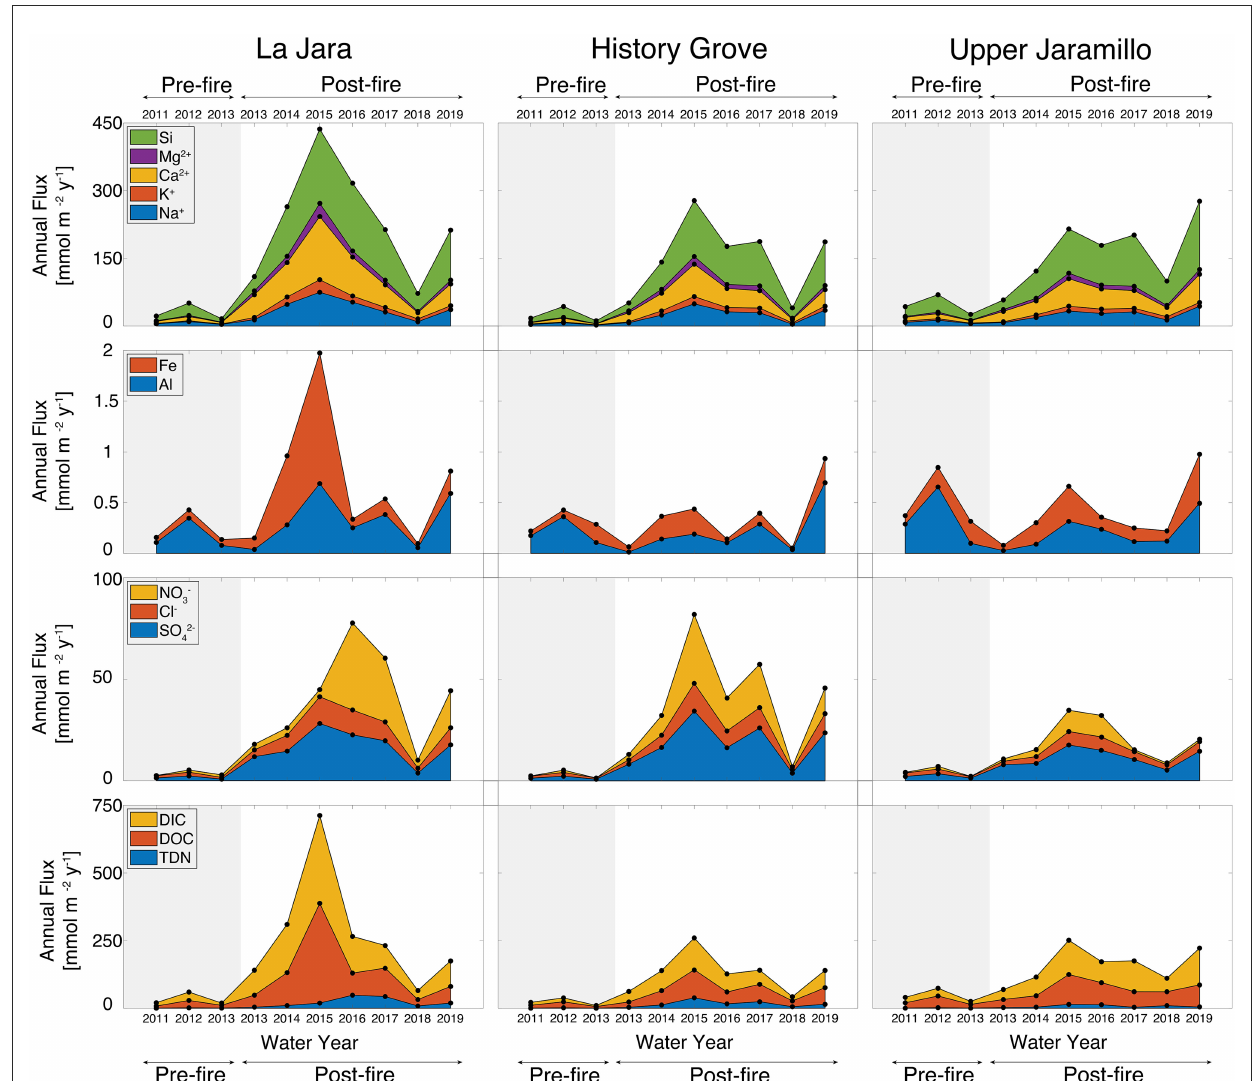
FIGURE5 Calculated annual fluxes and water yields of La Jara, History Grove, and Upper Jaramillo catchments. Notice that for the WY 2013 there are two calculated fluxes—before and after the Thompson Ridge Wildfire in the summer of 2013—in order to illustrate the immediate effect of the fire in the three headwater